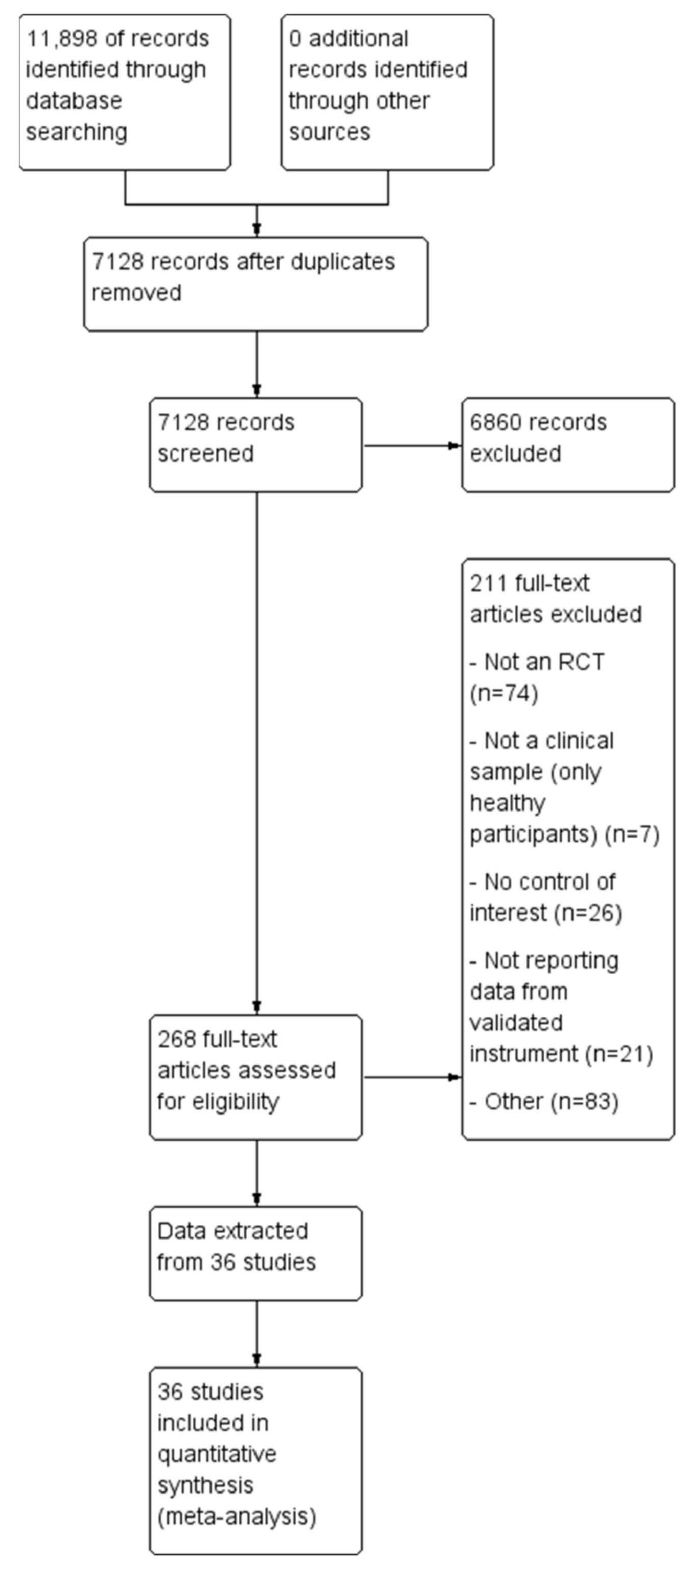
Figure 1. Study selection